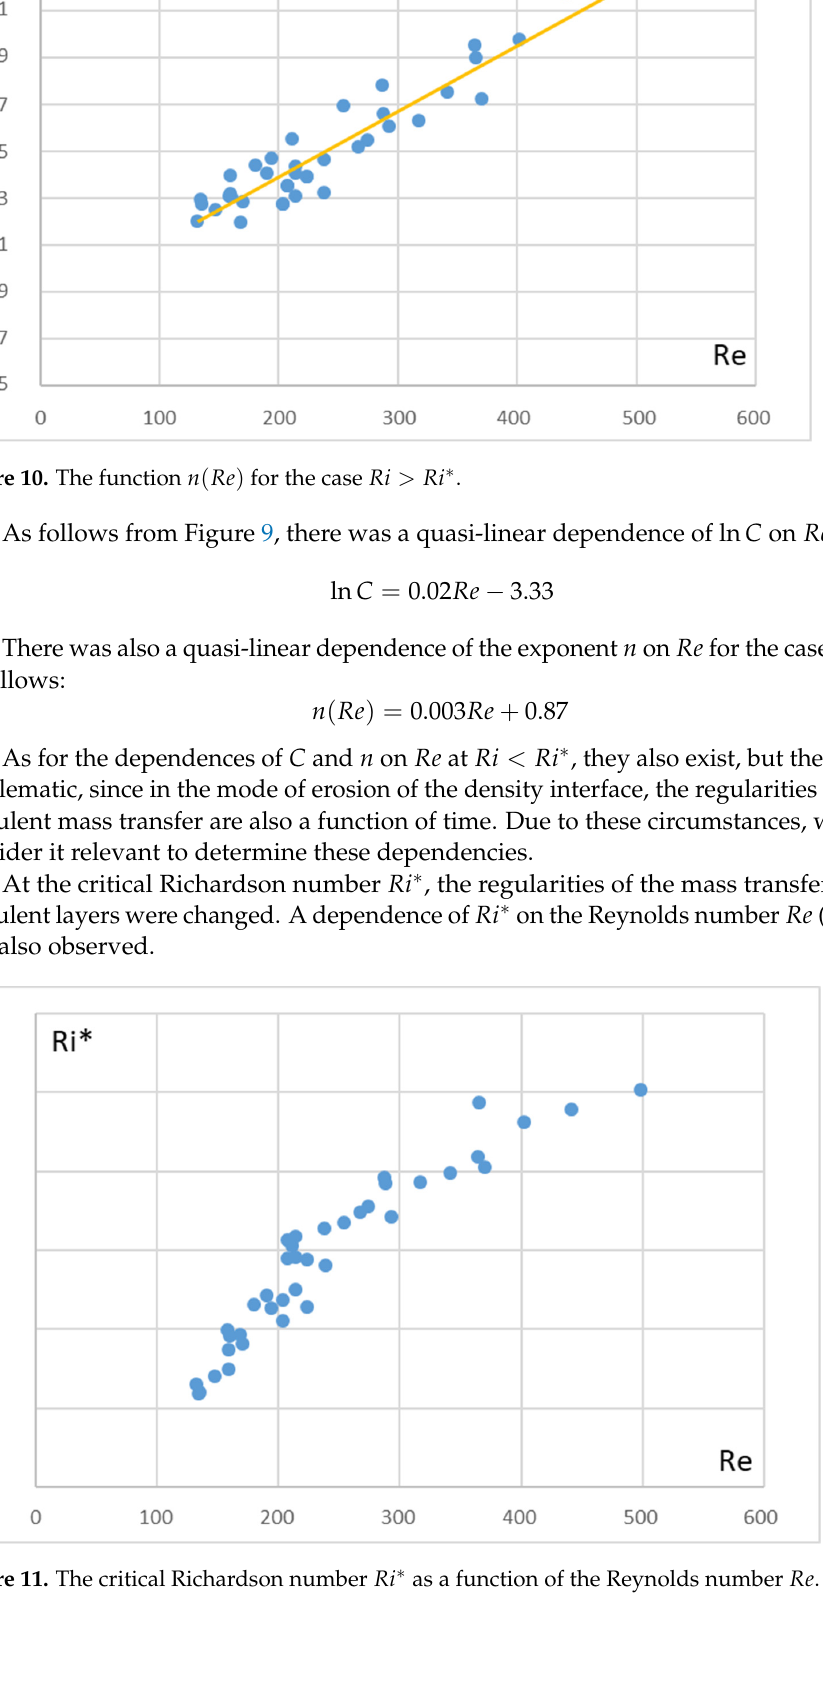
Figure 9. The dependence of ln(cid:1829) on (cid:1844)(cid:1857) for the case (cid:1844)(cid:1861) > (cid:1844)(cid:1861) ∗ .